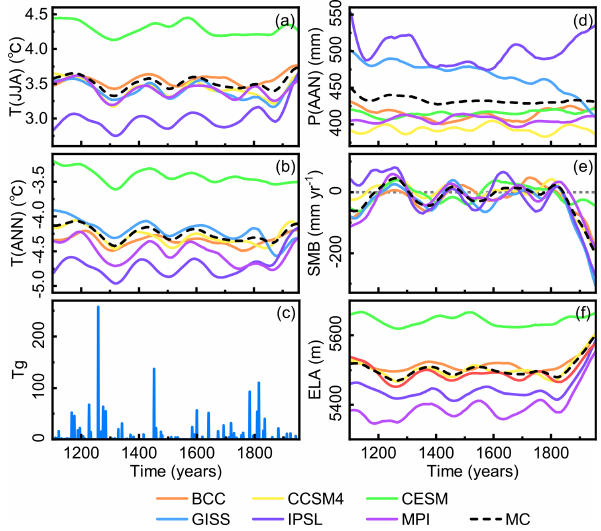
Figure 7. The regional average (a) summer temperature ( T (JJA)), (b) annual temperature ( T (ANN)), (d) annual precipitation ( P (ANN)), (e) SMB, (f) ELA from 1100 to 1950CE at a decadal timescale. (c) Global stratospheric sulfate aerosol loadings (Gao et al.,